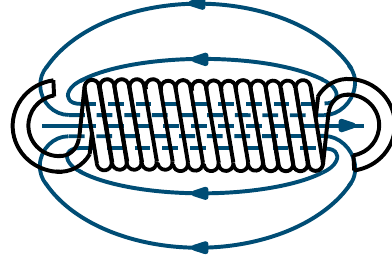
Figure 8. Coil spring modeled as an electric inductance (c.f. van der Weijde et al.